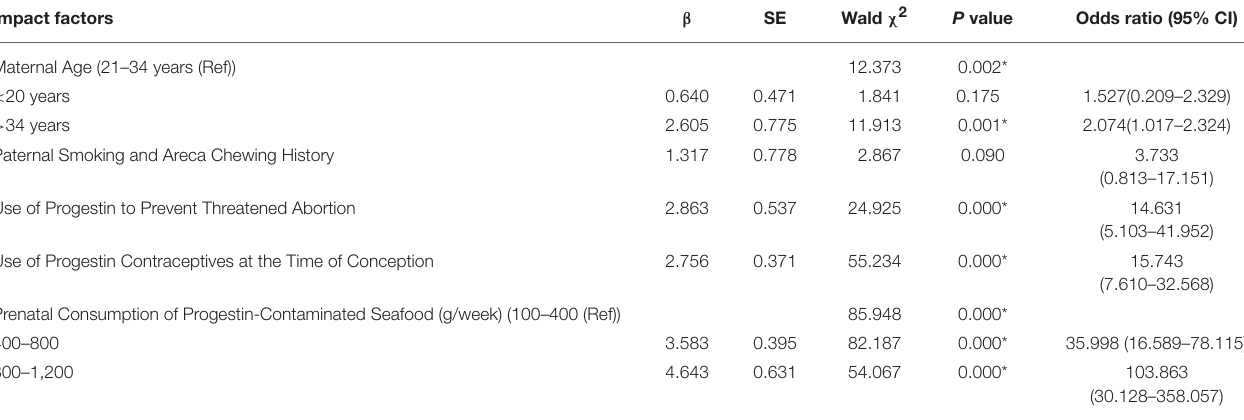
TABLE 6 | Multivariate logistic regression analysis for impact factors on ASD prevalence. Impact factors